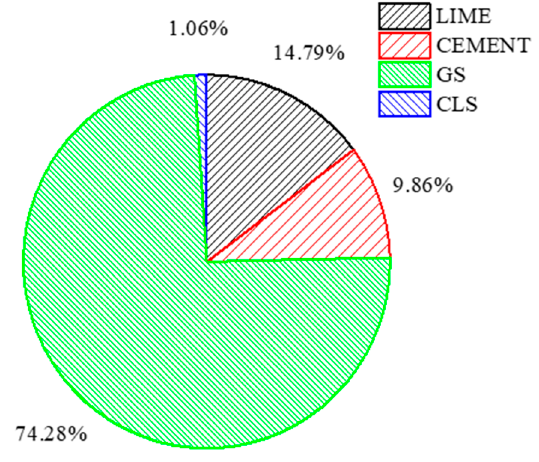
Figure 20. Variation in carbon emissions of materials for a haulage distance of 7 km.